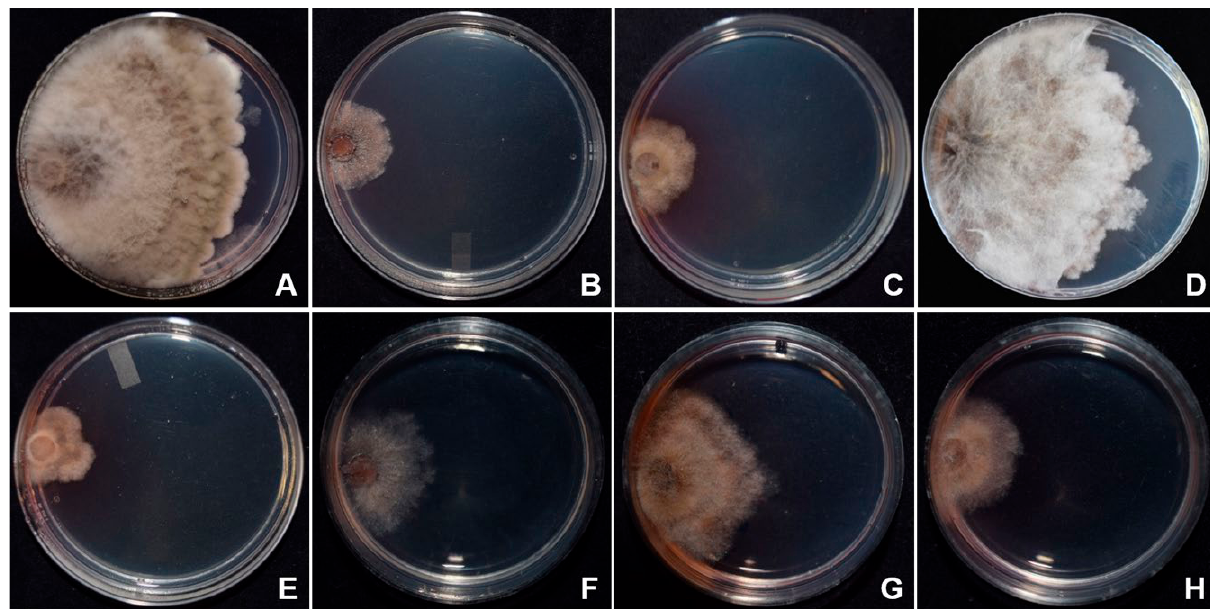
Figure 1. Growth of Lasiodiplodia gilanensis on PDA medium with different melanin inhibitors: A) Control. B) PDA + 15 μg mL -1 tropolone (Tp), DOPA-melanin inhibitor. C) PDA + 500 μg mL -1 phthalide (Ph), DHN-melanin inhibitor. D) PDA + 100 μg mL -1 nitisinone (NTBC), pyomelanin inhibitor. E) PDA + Tp + Ph. F) PDA + Tp + NTBC. G) Ph + NTBC. H) Tp + Ph +